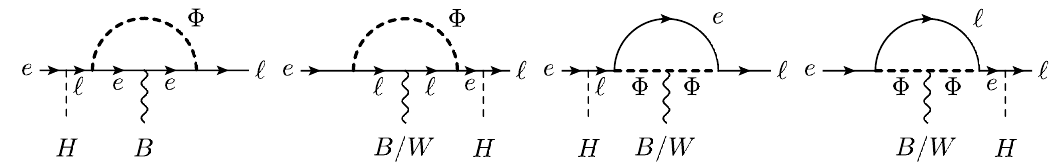
Figure 1. Feynman diagrams generating the dipole part of e → ‘B and e → ‘W amplitudes. Note that the Higgs boson cannot connect to the fermion inside the loop because of hypercharge